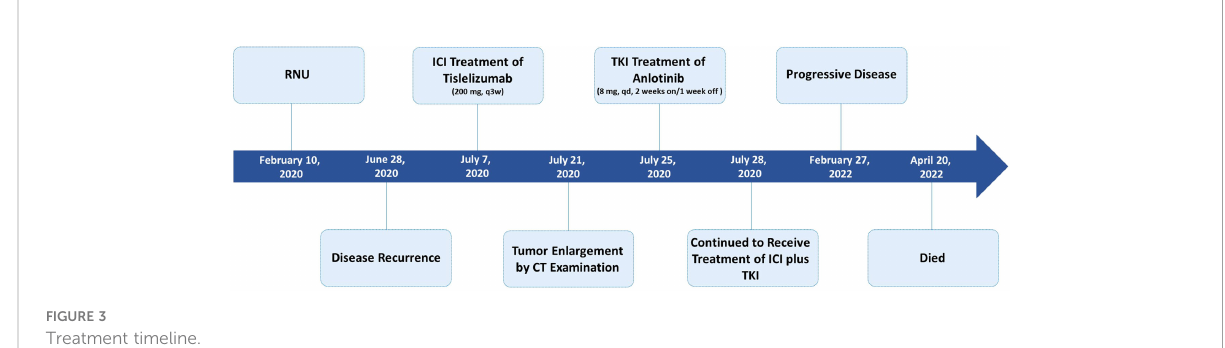
FIGURE 3 Treatment